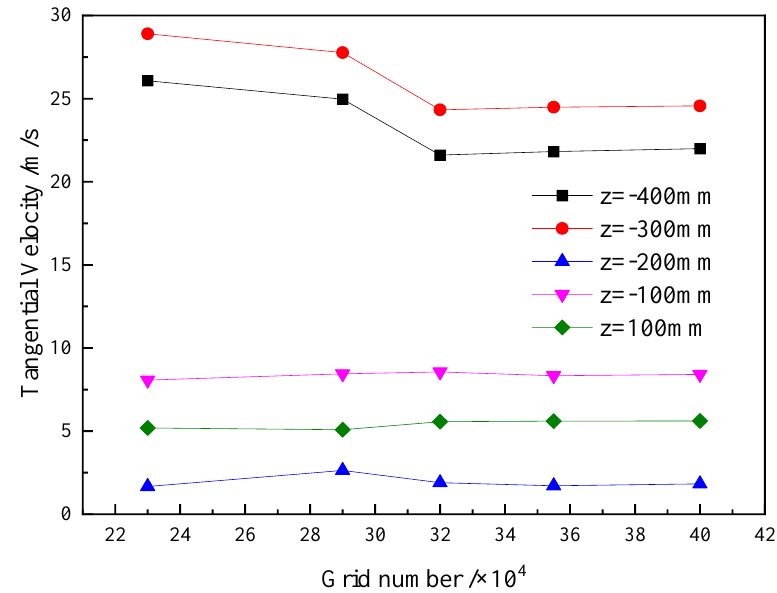
Figure 3. The influence of grid number on tangential velocity.